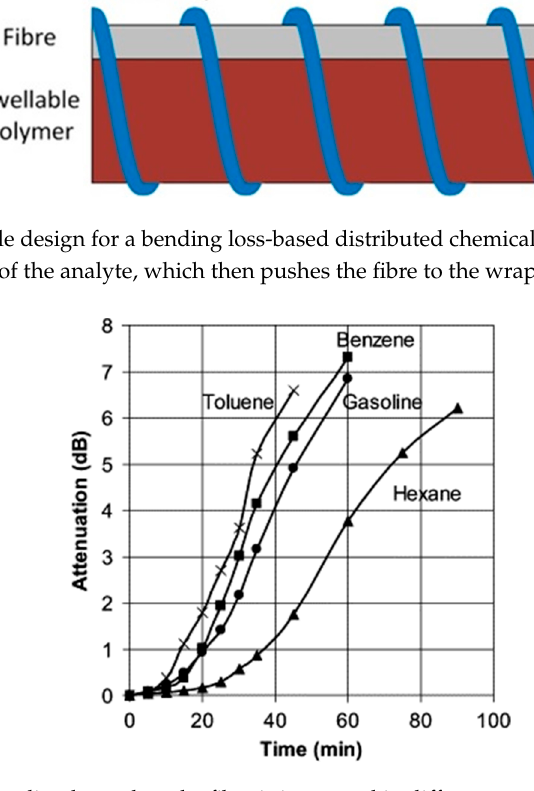
Figure 7. Measured bending loss when the fibre is immersed in different organic solvents. Reproduced with permission from Reference [44].